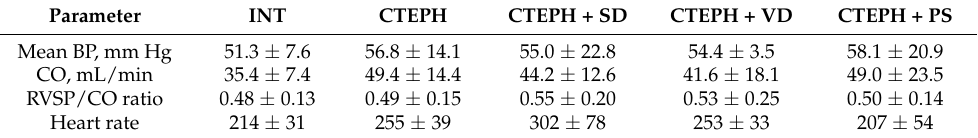
Table 3. Table 3. Invasive hemodynamic parameters result six weeks follow up after last microspheres ad- ministration.